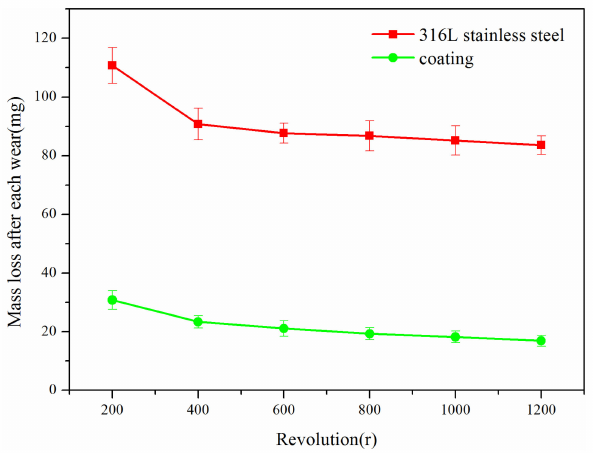
Figure 6. Comparison of abrasive wear properties between the coating and 316L stainless steel.